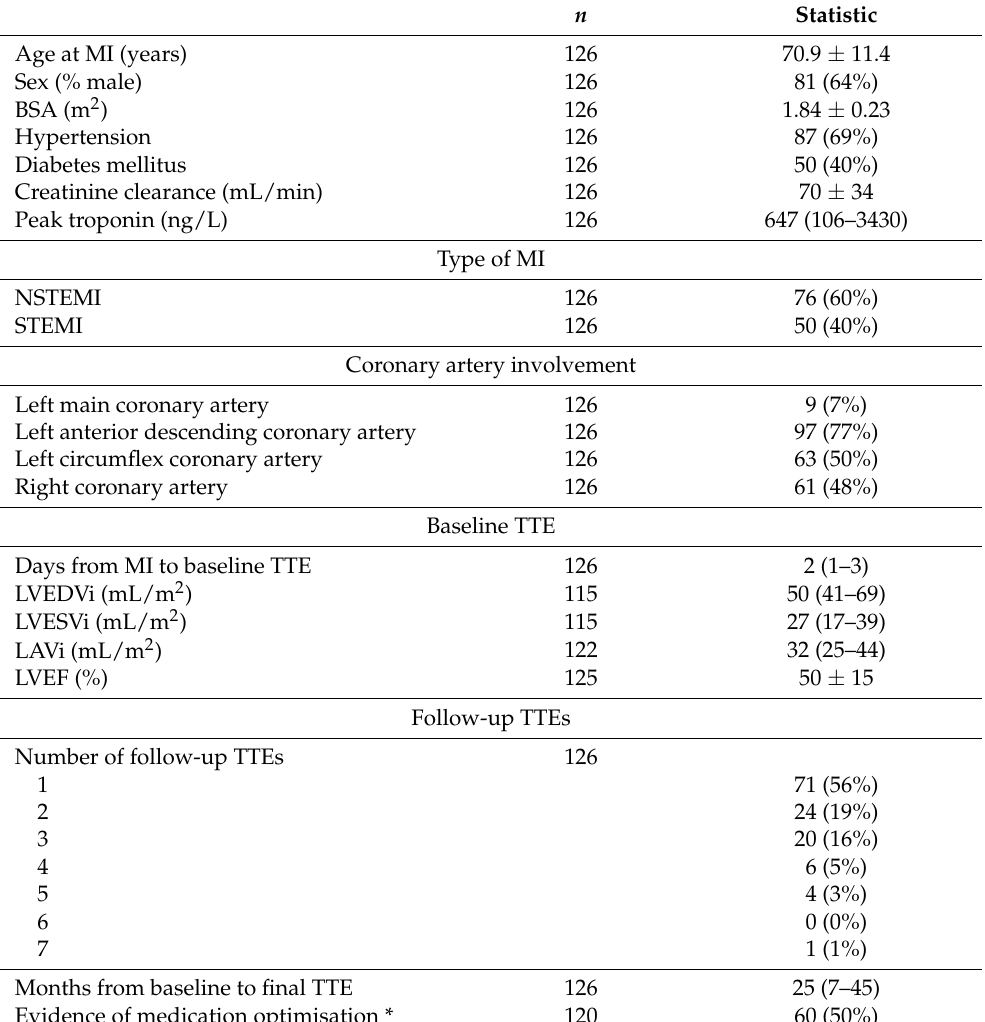
Table 1. Patient